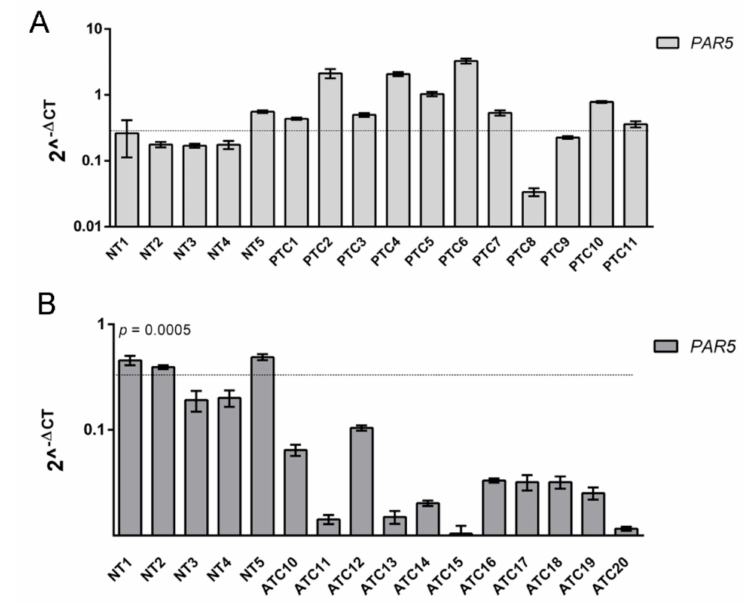
Figure 2. Analysis of Prader Willi / Angelman region RNA5 ( PAR5 ) expression in thyroid cancer. ( A ) qRT-PCR analysis was performed in 11 papillary thyroid carcinomas (PTC) and ( B ) an additional 11 ATC samples. t -test: p = 0.0005 (ATC vs. NT) to evaluate the expression levels of PAR5 . The dashed line represents the average relative expression levels of five NT samples. Data are reported as 2 − ∆ Ct values ±